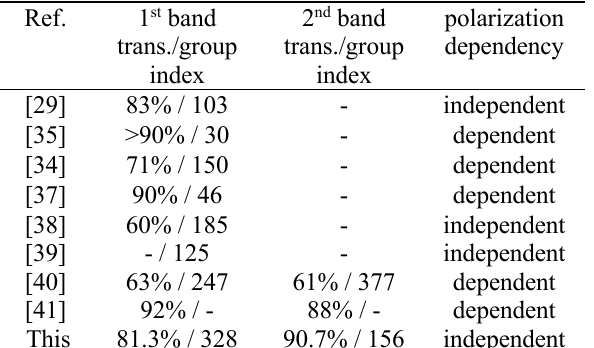
Figure 5: Group delay spectrum of the proposed dual-band polarization independent EIT-like metamaterial. Table 1: Comparison of transmission, group index and polarization dependency properties of EIT-like metamaterials.